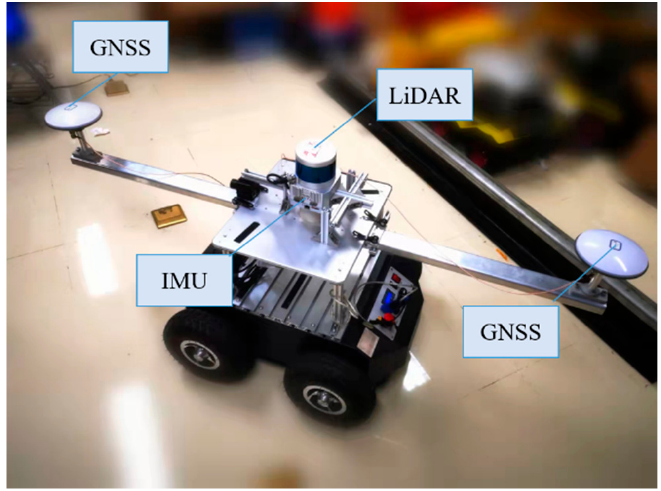
Figure 2. Unmanned vehicle hardware platform.